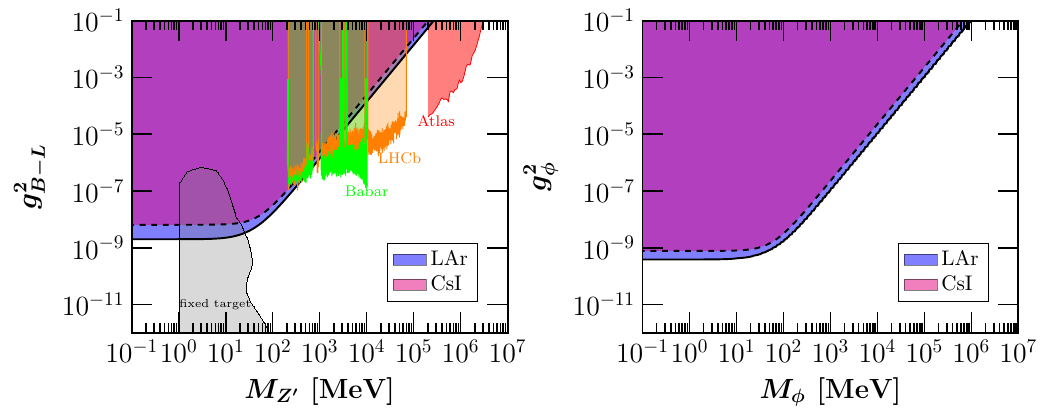
Figure 1 . Excluded region at 90% C.L in the parameter space ( M Z 0 , g 2 scenario (left) and ( M Φ , g 2 ) for the scalar mediator scenario (right), from the analysis of the recent Φ LAr data. In both cases, a comparison is given with the CsI